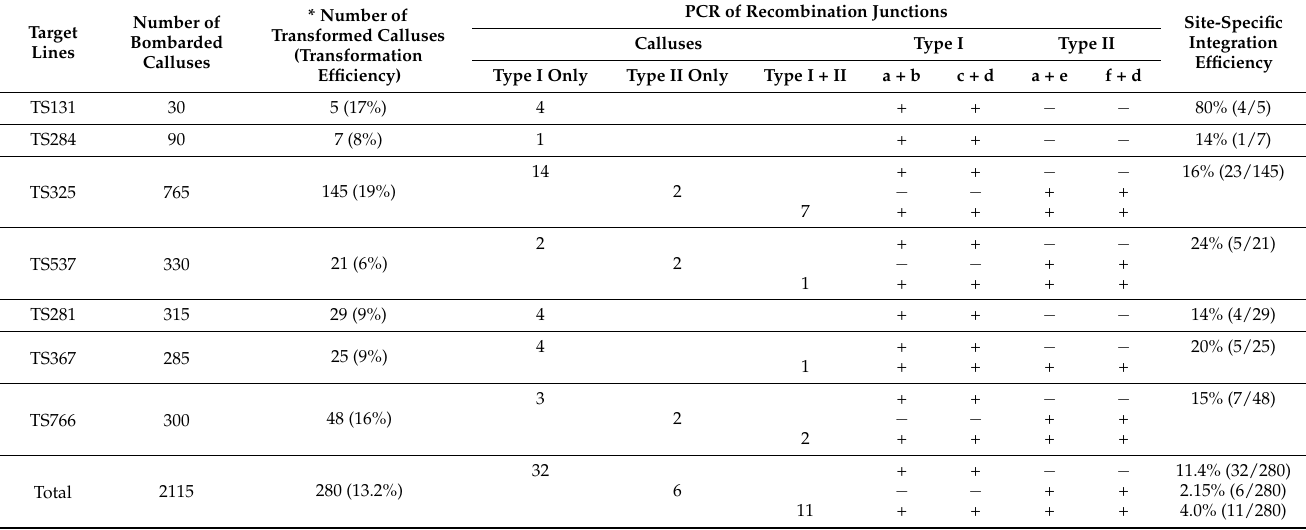
Table 1. Detection of site-specific integration in rice